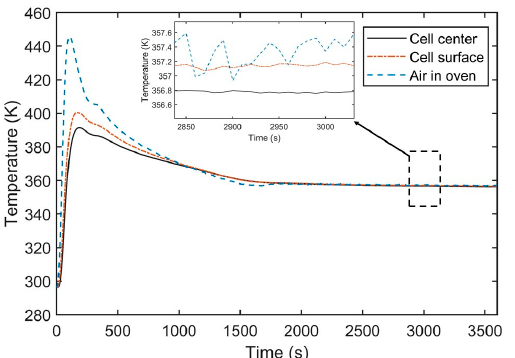
Figure 7. Experimental results at various temperatures. The temperature of the cell center is plotted as a solid line, the temperature of the cell surface is plotted as a dash–dotted line, and the temperature of the oven is plotted as a dotted line.